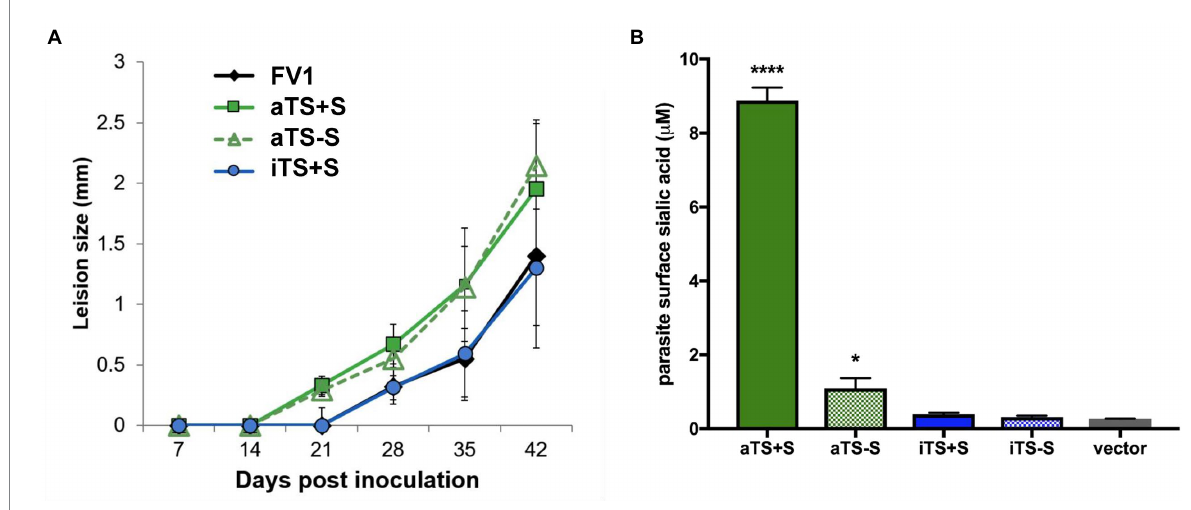
FIGURE 6 Expression of active TS enhances Leishmania virulence. Mice were inoculated by footpad injection with FV1 L. major parasites transfected with a control vector (NC), active secreted TS (aTS+S), active nonsecreted TS (aTS − S), or inactive secreted TS (iTS+S). (A) Footpad caliper measurements demonstrated that L. major parasites expressing active forms of TS caused footpad lesions approximately 7 days earlier than L. major parasites expressing inactive TS or control vector. (B) Earlier lesion development in mice inoculated with parasites expressing active TS was associated with surface sialylation of these